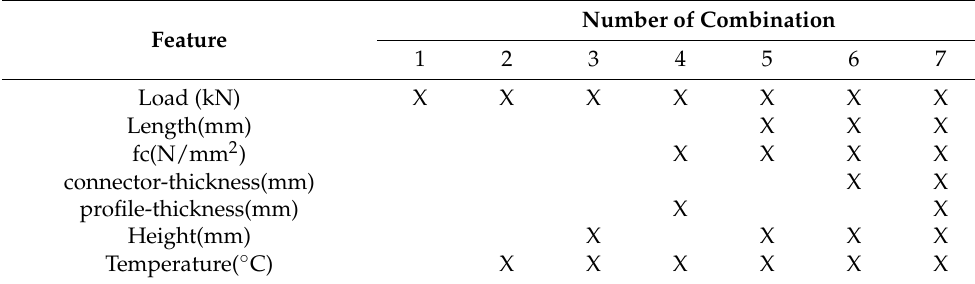
Table 11. Most effective inputs based on feature selection.